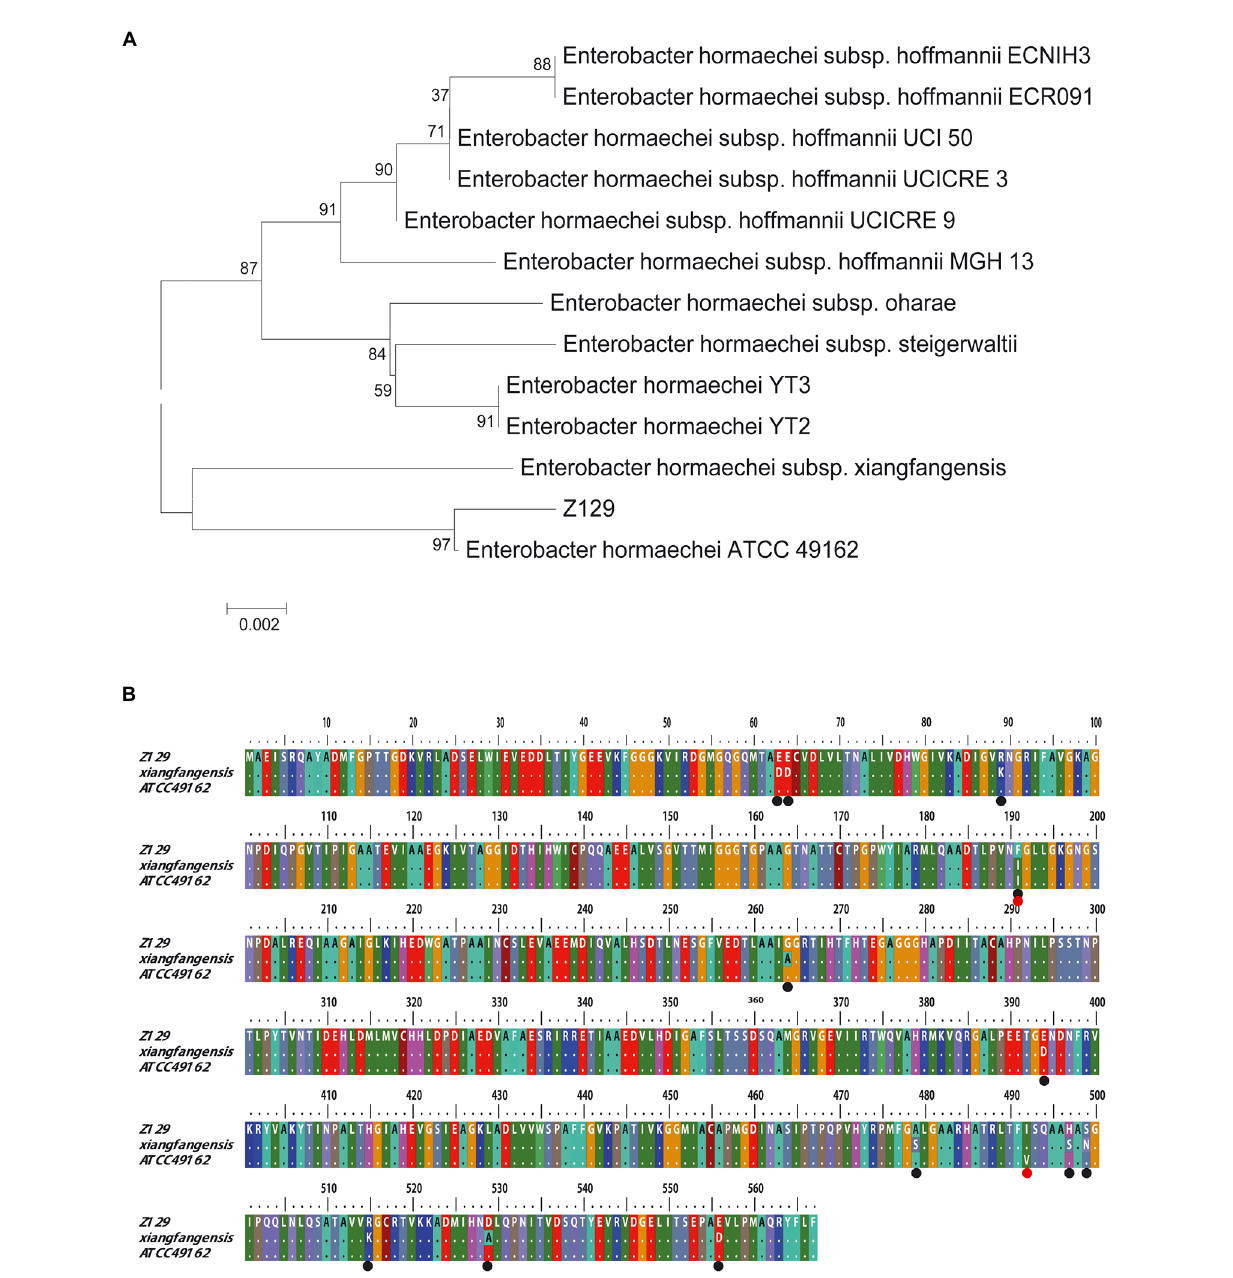
FIGURE 5 Comparative analysis of Z129 and 12 other Enterobacter hormaechei strains based on UreC AA sequence. (A) Phylogenetic tree based on UreC AA sequence. (B) Alignment of UreC AA sequences among Z129, E. hormaechei subsp. xiangfangensis and E. hormaechei ATCC 49162. The black circles indicate the different sites between Z129 and E. hormaechei subsp. xiangfangensis , and the red circles indicate the different sites between Z129 and E. hormaechei ATCC